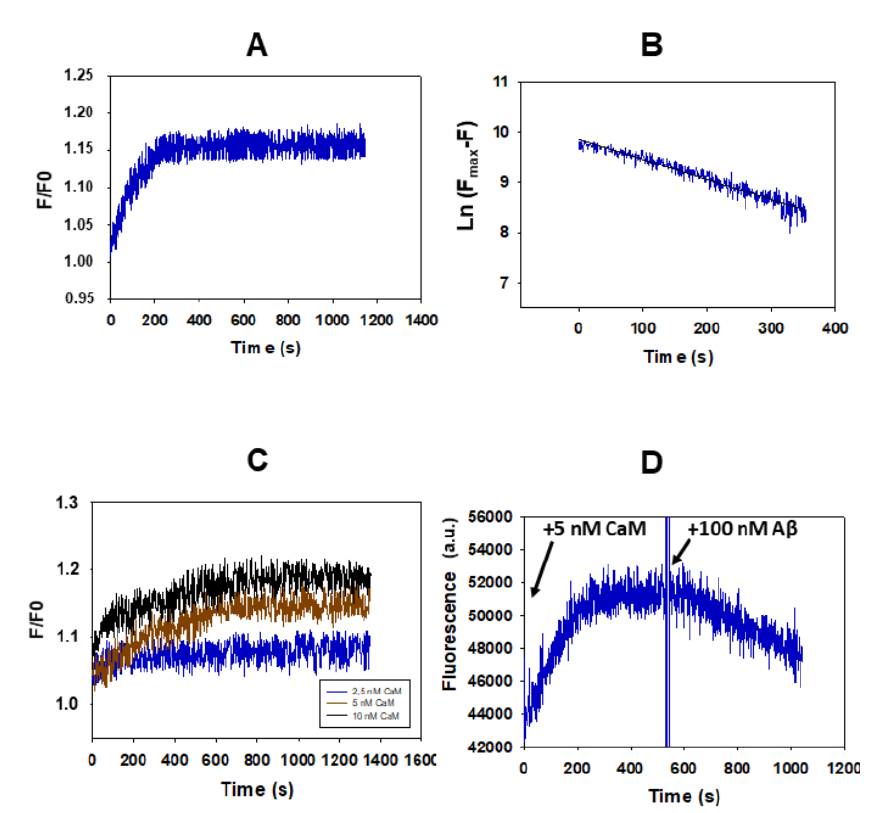
Figure 1. The kinetics of complex formation between A β (1–42) and CaM monitored by the increase in the fluorescence of A β (1–42) HiLyte TM -Fluor555. ( A ) A representative kinetic recording of the increase in the fluorescence intensity of 10 nM of A β (1–42) HiLyte TM -Fluor555 after the addition of 5 nM of CaM. ( B ) The increase in fluorescence of A β (1–42) HiLyte TM -Fluor555 has been fit to a first-order kinetic process. F max is the maximum fluorescence intensity at the completion of the kinetic process. The black continuous line is the linear least-squares fit of the data of the panel A to the equation: y = 9.845 − 0.00396 x (R 2 = 0.922). ( C ) The dependence of the kinetics of increase in fluorescence intensity of 10 nM of A β (1–42) HiLyte TM -Fluor555 upon the following concentrations of CaM: 2.5 nM (blue), 5 nM (brown) and 10 nM (black). ( D ) A reversion of the increase in fluorescence of A β (1–42) HiLyte TM -Fluor555 elicited by 5 nM of CaM by the addition of 100 nM of A β (1–42) at the point indicated by an arrow. The fluorescence measurements have been performed as indicated in the Materials and Methods, and a.u. means fluorescence units given by the fluorimeter